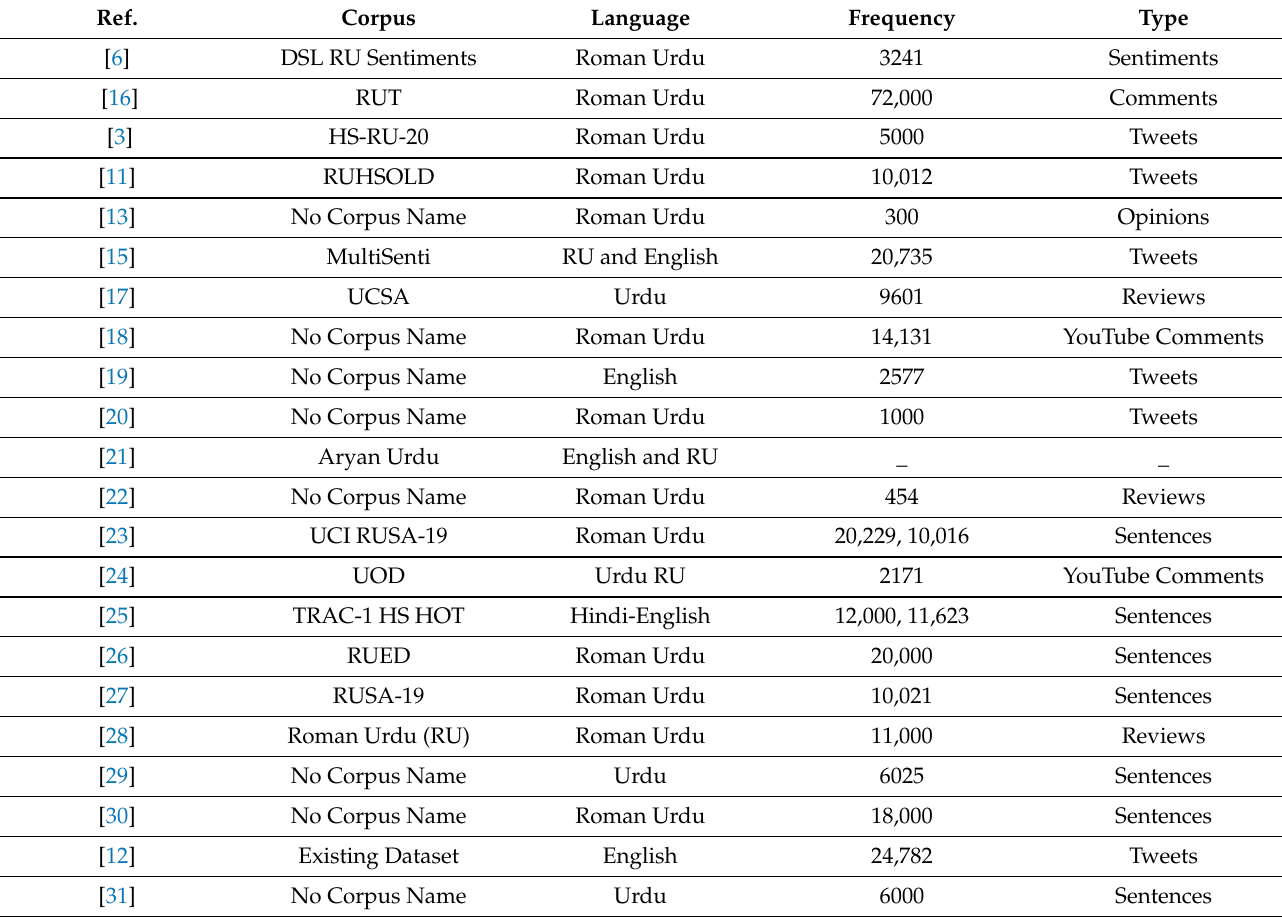
Table 1. Publicly available Urdu and Roman Urdu datasets along with their characteristics.